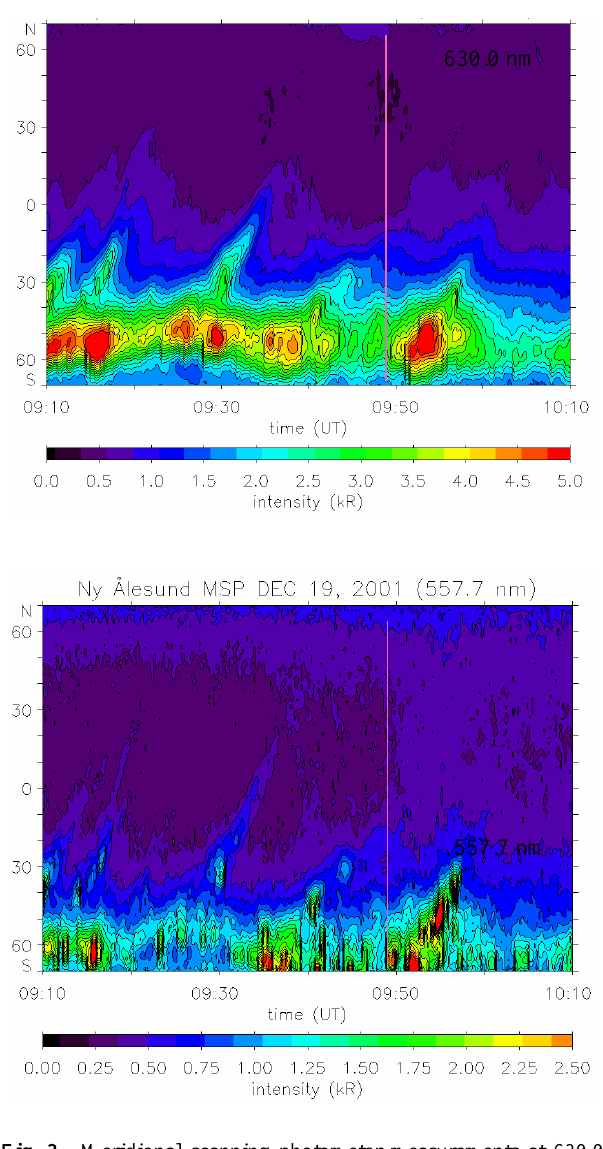
Fig. 3. Meridional scanning photometer measurements at 630.0 (top) and 557.7nm (bottom) acquired between 09:10:00 and 10:10:00 UT on 19 December